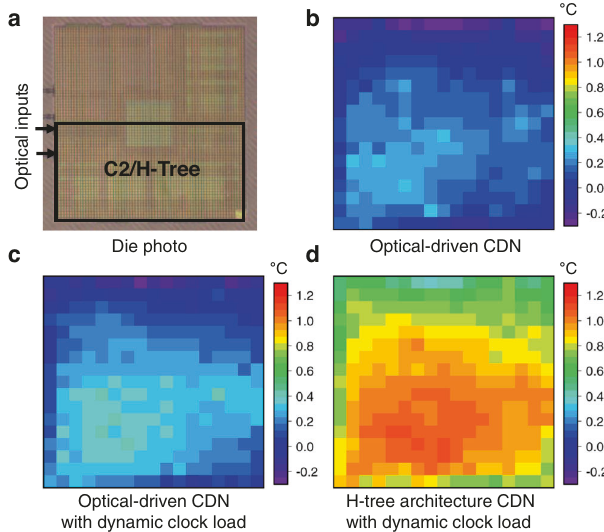
Fig. 6 | Die thermal map. a Die photo. The operated partial region for thermal analysis is shown as a solid box. b Temperature rise compared to bare die when optical input isentered to generate digital clock through proposed optical CDN. A maximum and mean temperature rise of 0.3°C and 0.1°C have been observed. c Thermal image when optical CDN is operated with dynamic clock load. A max- imum and mean temperature rise are 0.4°C and 0.2°C, respectively. d Thermal imagewhenH-treeCDNisdriven.Amaximumandmeantemperatureriseare1.1°C and 0.9°C,